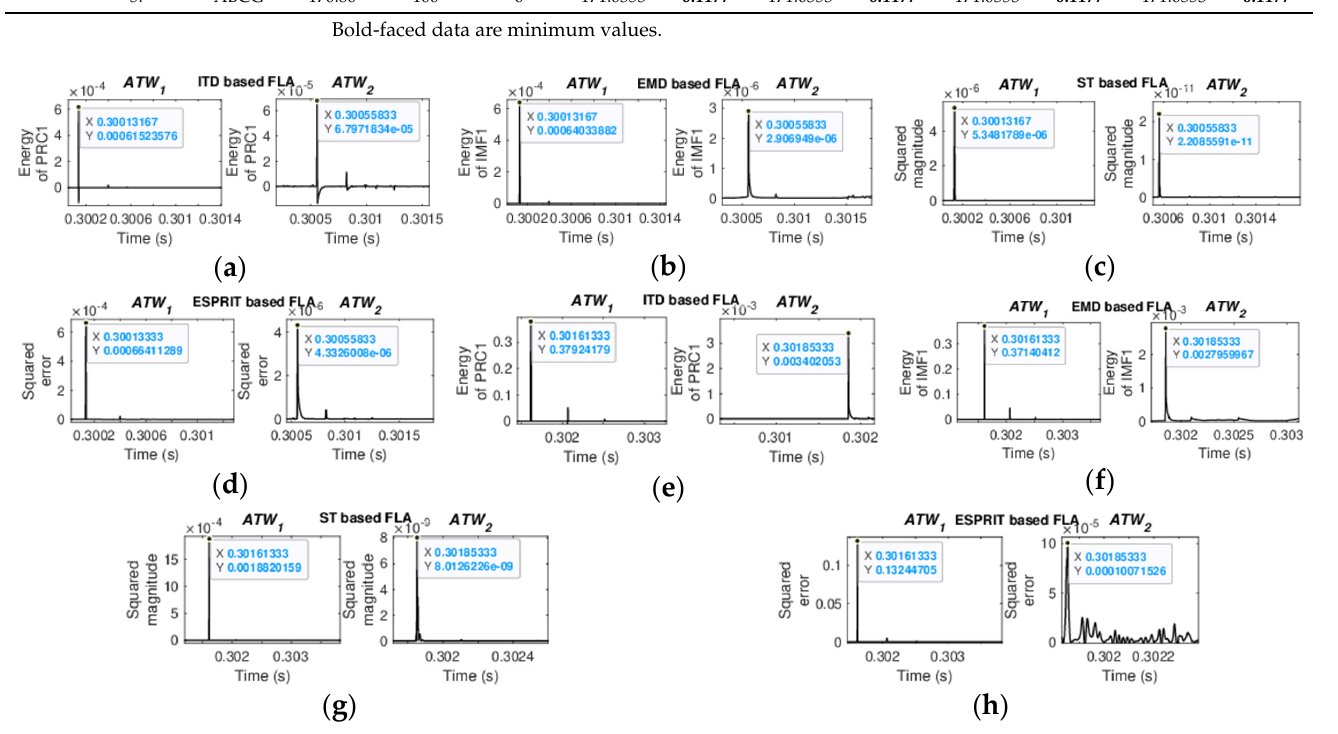
Table 1. Performance under series compensation (mid-point connected SSSC).